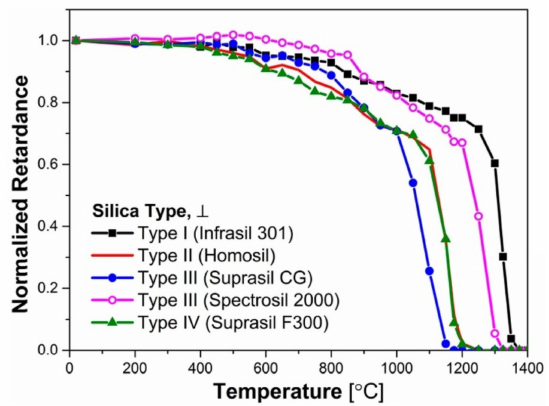
Figure 17. Influence of impurities on glass stability, as deduced by measuring the retardance of embedded nanogratings (reproduced from